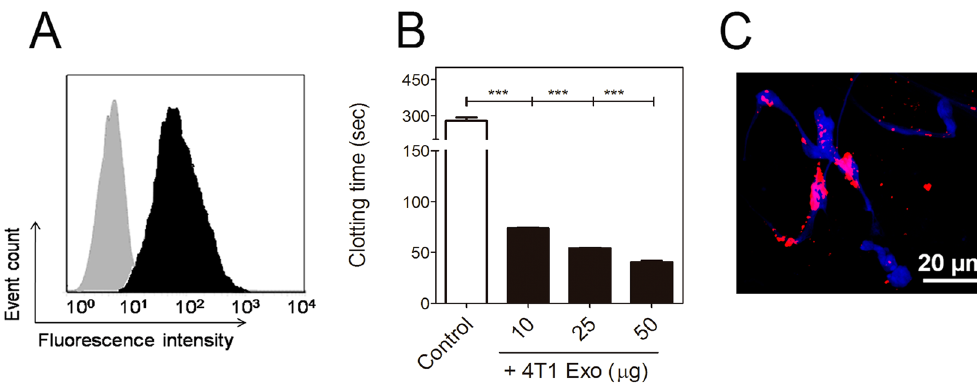
Figure 5. NETs interact with tumor-derived procoagulant exosomes. ( A ) Flow-cytometric analysis of TF expression in 4T1 cells. Black region represents labeling with a rabbit polyclonal anti-murine TF antibody and a phycoerythrin-conjugated secondary antibody. Gray regions represent cells labeled with IgG isotype control and the same phycoerythrin-conjugated secondary antibody. ( B ) Procoagulant activity of 4T1- derived exosomes. Exosomes were isolated and quantified from culture supernatants and further assayed for procoagulant activity, as described in the Methods section. Control bar represents the coagulation time of murine plasma alone. The asterisks indicate P < 0.001 relative to control plasma (Student’s t-test). Experiments were performed in triplicate. ( C ) Representative image showing 4T1-derived exosomes interacting with NETs. Exosomes were labeled with DilC18 (red), and NET DNA was stained with Hoechst 33342 (blue). Cells were isolated and stimulated with PMA for 3 hs to induce NET formation, before incubation with 4T1 exosomes. Scale bar = 20 μ